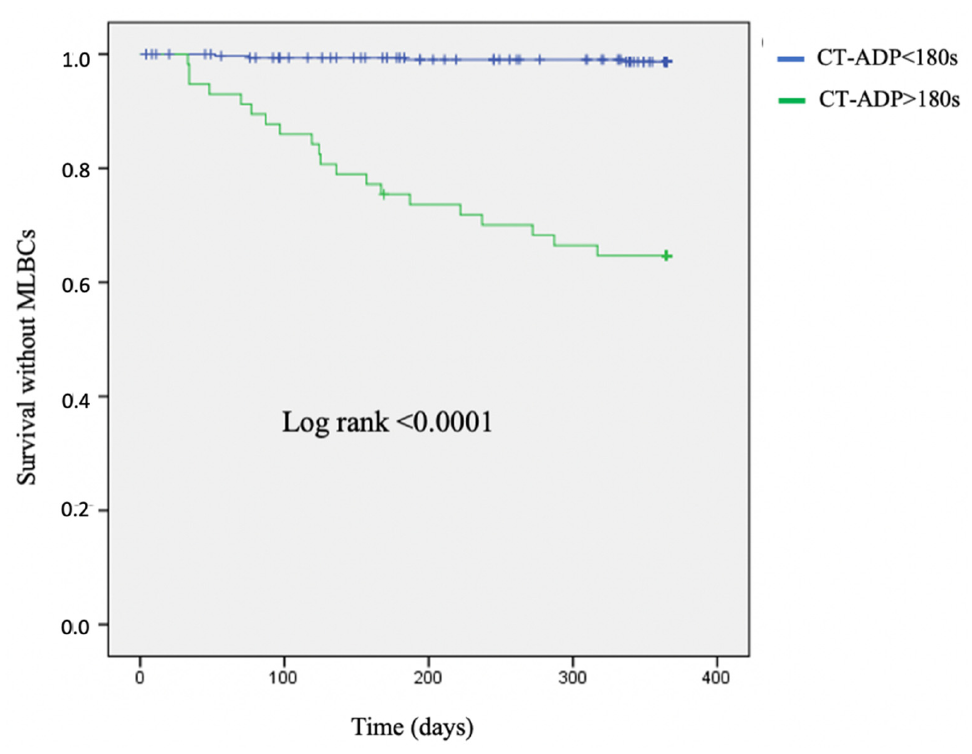
Figure 2. Kaplan–Meier curves. Survival without late major or life-threatening bleeding complica- tions (MLBCs) according to a post-procedural CT-ADP threshold of > 180 s. ADP = adenosine diphos- phate; CT-ADP = closure time with ADP; MLBCs = major or life-threatening bleeding complications. According to the multivariate analysis, dialysis (HR 6.45; 95% CI 1.05–39.49; p = 0.044), LVMi (HR 1.01; 95% CI 1.00–1.02; p = 0.033), baseline anemia, thrombopenia (HR 0.76; 95% CI 0.62–0.95; p = 0.013 and HR 0.99; 95% CI 0.98–1.00; p = 0.002, respectively), and significant PVL (HR 2.74; 95% CI 1.26–5.94; p = 0.011) were evidenced as independent